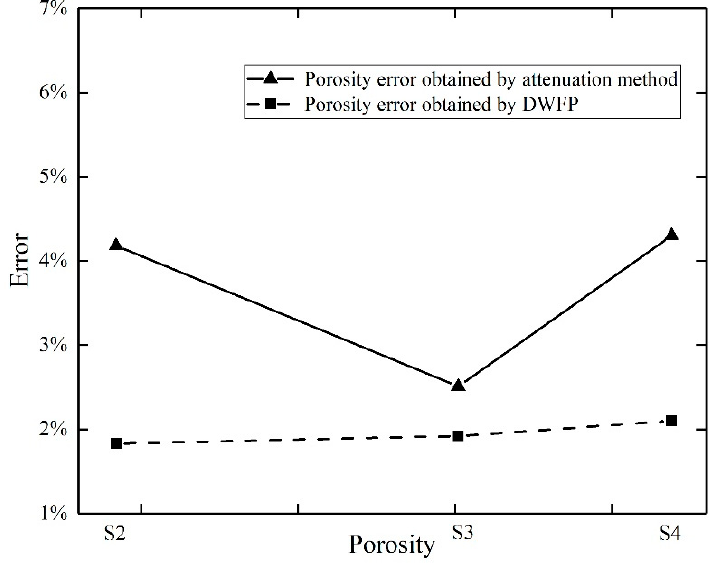
Figure 10. Error diagram obtained using two signal processing methods.